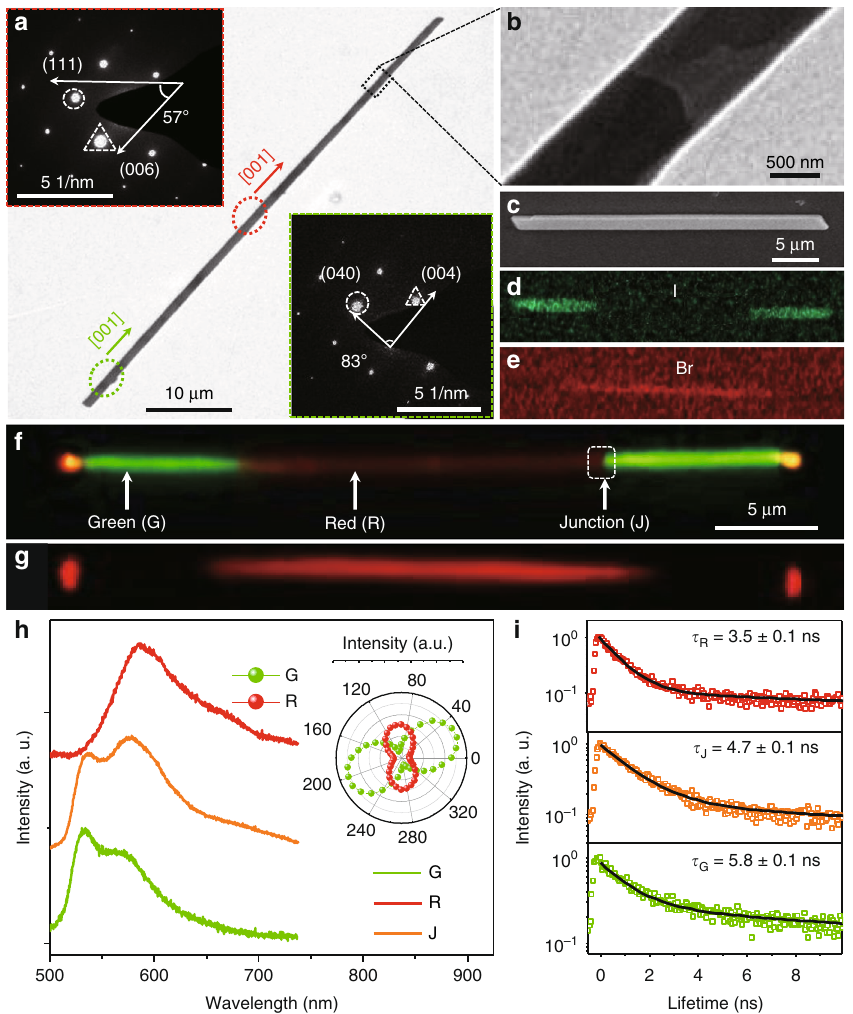
Fig. 2 Structure and optical characteristics of TNWs. a The TEM image of one typical TNW, scale bar: 10 μ m. The SAED patterns at the upper-left and the below-right insets correspond to the center part with red marked area and the end part green marked area in TNWs, respectively. b The magni fi ed image of the junction in the TNW, scale bar: 500 nm. c The SEM image of one typical TNW; scale bar: 5 μ m. The corresponding energy-dispersive X-ray spectroscopy (EDS) mapping for elements ( d ) iodine (I) and ( e ) bromide (Br), respectively. The FM images of one typical TNW excited with ( f ) the UV band and ( g ) the green band (500 – 550 nm), scale bar: 5 μ m. h Spatially resolved PL spectra and i PL decay curves collected from different locations marked in ( f ). Inset of h : the corresponding polar image of the peak